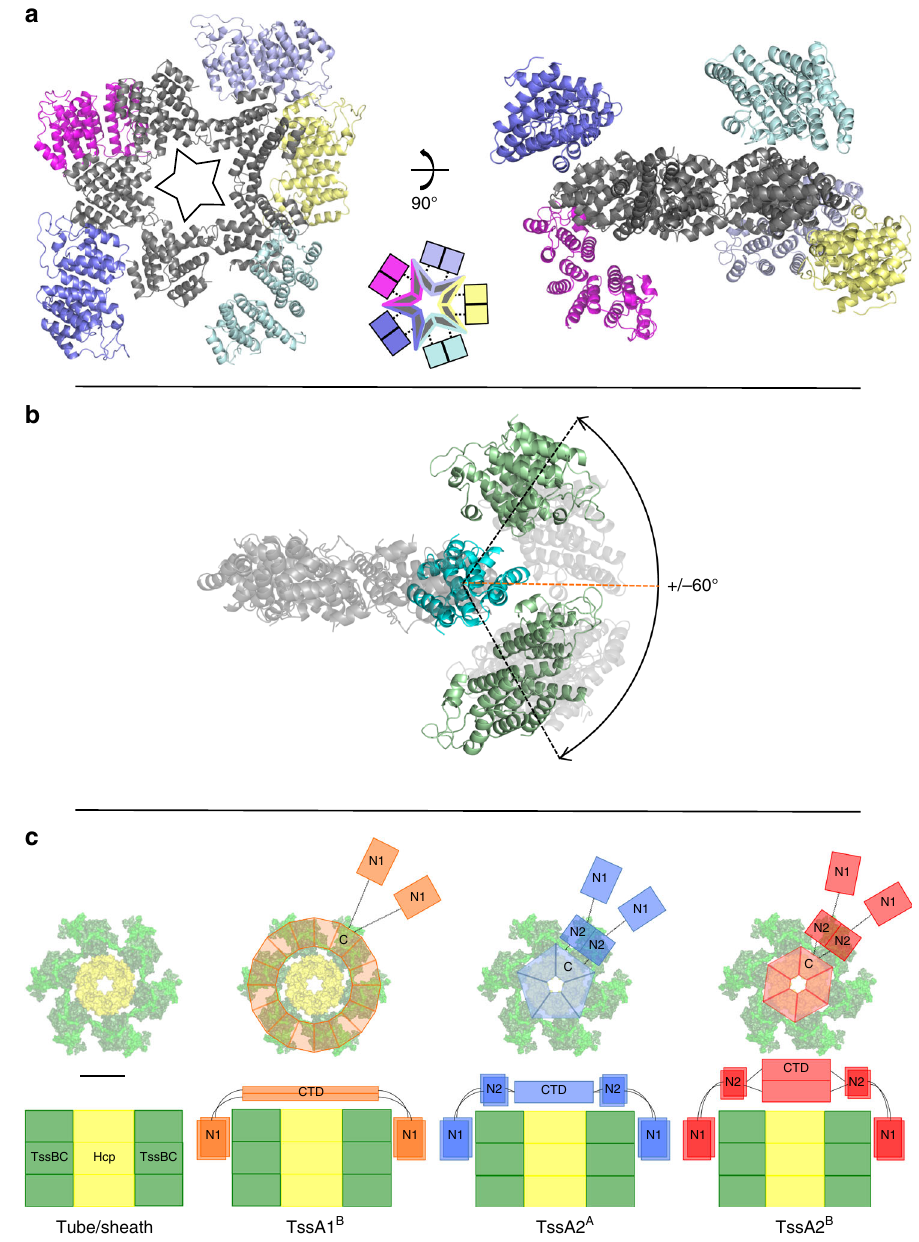
Fig. 7 Schematic representation of TssA ring dimensions and domain fl exibility. a Arrangement of the Ah TssA2 A Nt2 domains around the CTD oligomer as observed in the asymmetric unit. The Nt2 domains do not follow strict fi ve-fold symmetry. The decameric CTD ring is shown in dark grey perpendicular to the fi ve-fold (left) and two-fold (right) axes with each peripheral Nt2 dimer shown in a different colour. The diagram between the two structures shows the relationship between dimer-forming Nt2 domains (represented by coloured squares) and their corresponding C-terminal domains in the TssA2 A Nt2-CTD decamer. b Displacement of the Ah TssA2 A Nt2 dimers perpendicular to the fi ve-fold axis of the CTD oligomer. The CTD ring is shown in light grey with one WEP-mediated CTD dimer indicated in cyan to which is tethered an Nt2 dimer. The Nt2 dimer (light green) is shown at its maximum displacement of ~60° either side of the plane of the CTD ring (orange line). Other observed positions of Nt2 are indicated by translucent shading. c Top and side view representations showing the domain architecture of TssA subunits from clades 1 B , 2 A and 2 B modelled on the baseplate-distal end of the T6SS tube/sheath assembly during polymerisation. The V. cholerae TssBC extended sheath (green) surrounding a Hcp hexamer (yellow) (PDB: 5MXN) is shown on the left. Onto this, is modelled the TssA1 B CTD oligomer (orange) with 16-fold symmetry, showing one stacked CTD dimer attached to a pair of Nt1 domains via fl exible linkers, the TssA2 A CTD oligomer (blue) with fi ve-fold symmetry, showing a WEP-mediated CTD dimer connected to the two monomers of an Nt2 dimer via fl exible linkers, each of which are in turn connected to an Nt1 domain, and the TssA2 B CTD oligomer (red) displaying six-fold symmetry, showing a CTD dimer connected to the two monomers of an Nt2 dimer via fl exible linkers, each of which are in turn connected to an Nt1 domain. Labels are: C, CTD dimers (top view); N1, Nt1; N2, Nt2; CTD, CTD oligomer (side view). Scale bar corresponds to 65